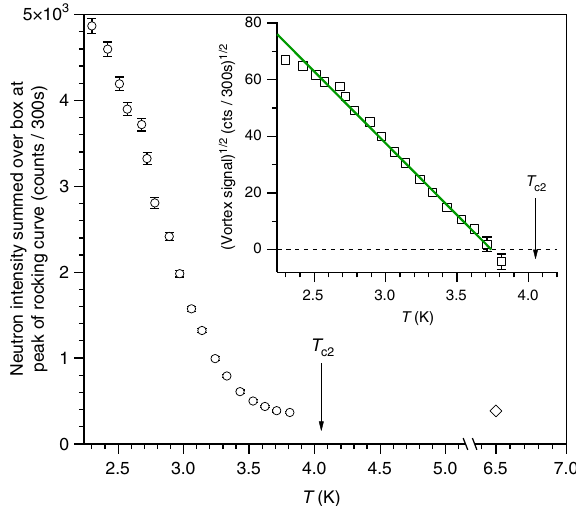
Fig. 6 Temperature dependence at 0.13 T. Neutron scattering from the vortex ensemble is measured on warming, after fi eld-cooling to 2 K. Using the perpendicular fi eld geometry (Fig. 2b), neutron counts are collected at the peak of the rocking curve and summed over a box on the 2D multidetector encompassing the Bragg spot (red box in Fig. 2b). The diamond indicates a background measurement at T > T c characterising the non-vortex scattering that arises predominantly from the walls of the closed-cycle refrigerator used to cool the sample. Error bars are determined by Poisson statistics. Inset shows the square root of the vortex signal I p , which is proportional to the vortex form factor h when the fi eld is constant. q Negative values of vortex signal, arising from the background subtraction, (cid:7) (cid:7) (cid:1) (cid:3) ffiffiffiffiffiffiffi (cid:7) (cid:7) are indicated by plotting sgn I p I p . Green line is a guide to the eye showing a linear variation, as expected from mean fi eld theory in the vicinity of a phase